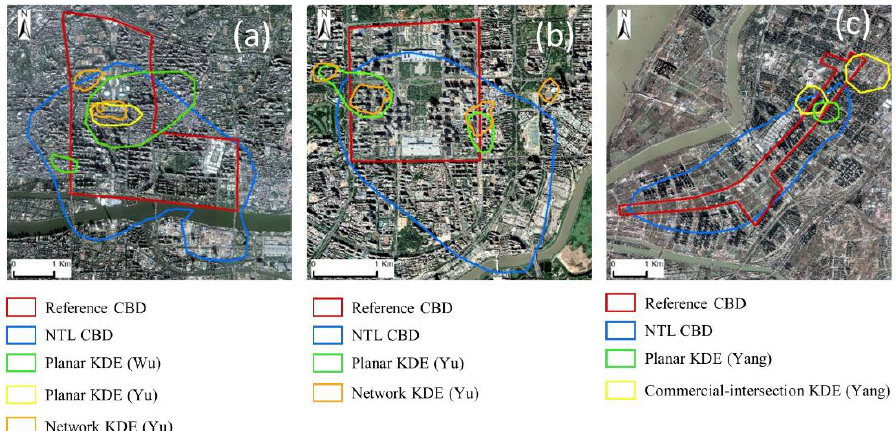
Figure 9. The comparison of CBDs from the proposed new method (NTL CBD) and GIS-based meth- ods. (a) Guangzhou; (b) Shenzhen; (c) Nanjing. methods. ( a ) Guangzhou; ( b ) Shenzhen; ( c )